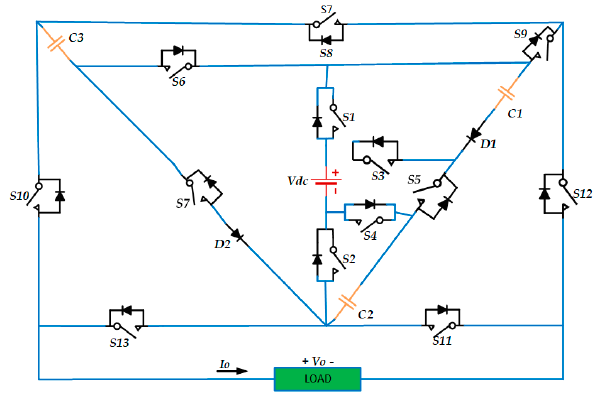
Figure 14. 13 − Level